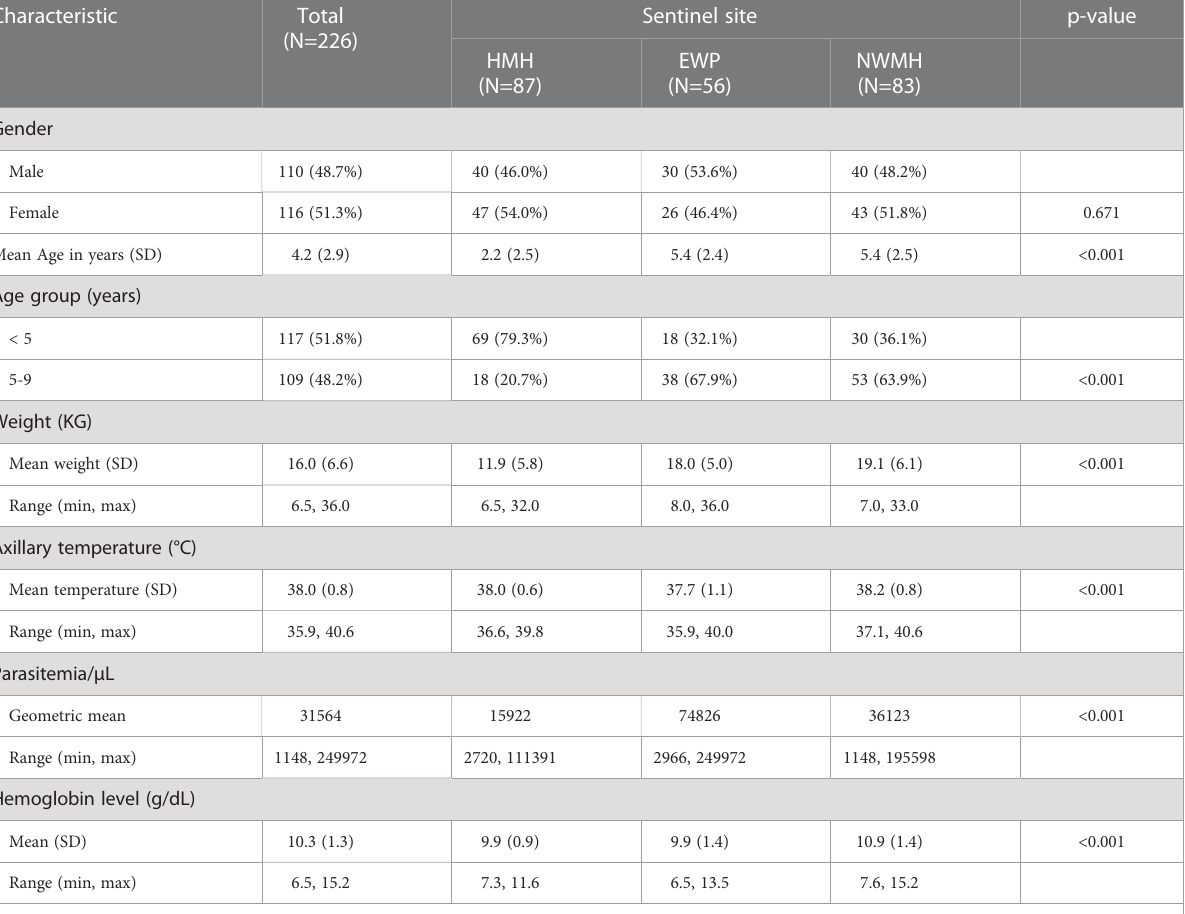
signi fi cantly higher than pre-treatment levels in all three sites (Table 4). The mean changes between day 28 and day 42 were signi fi cant in HMH and EWP (p<0.001 and p=0.006, respectively) but not WMH (p=0.075). Vomiting was the main adverse event reported. Prevalence